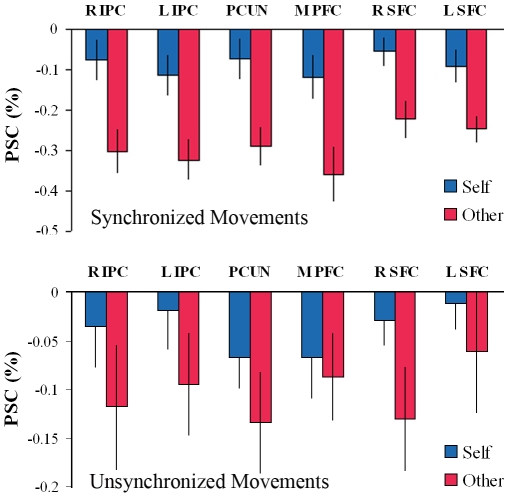
BOLD activations in the intrinsic ROIs by stimulus type.BOLD activations in intrinsic ROIs during passive blocks by response type, separately for synchronized movements -view-self condition (upper panel) and for unsynchronized movements – view other condition (lower panel). The subjective attribution of the viewed movement to self was associated with higher levels of BOLD activation in the intrinsic ROIs even though all external parameters were identical, and regardless of movement synchrony. Error bars =  SEM.